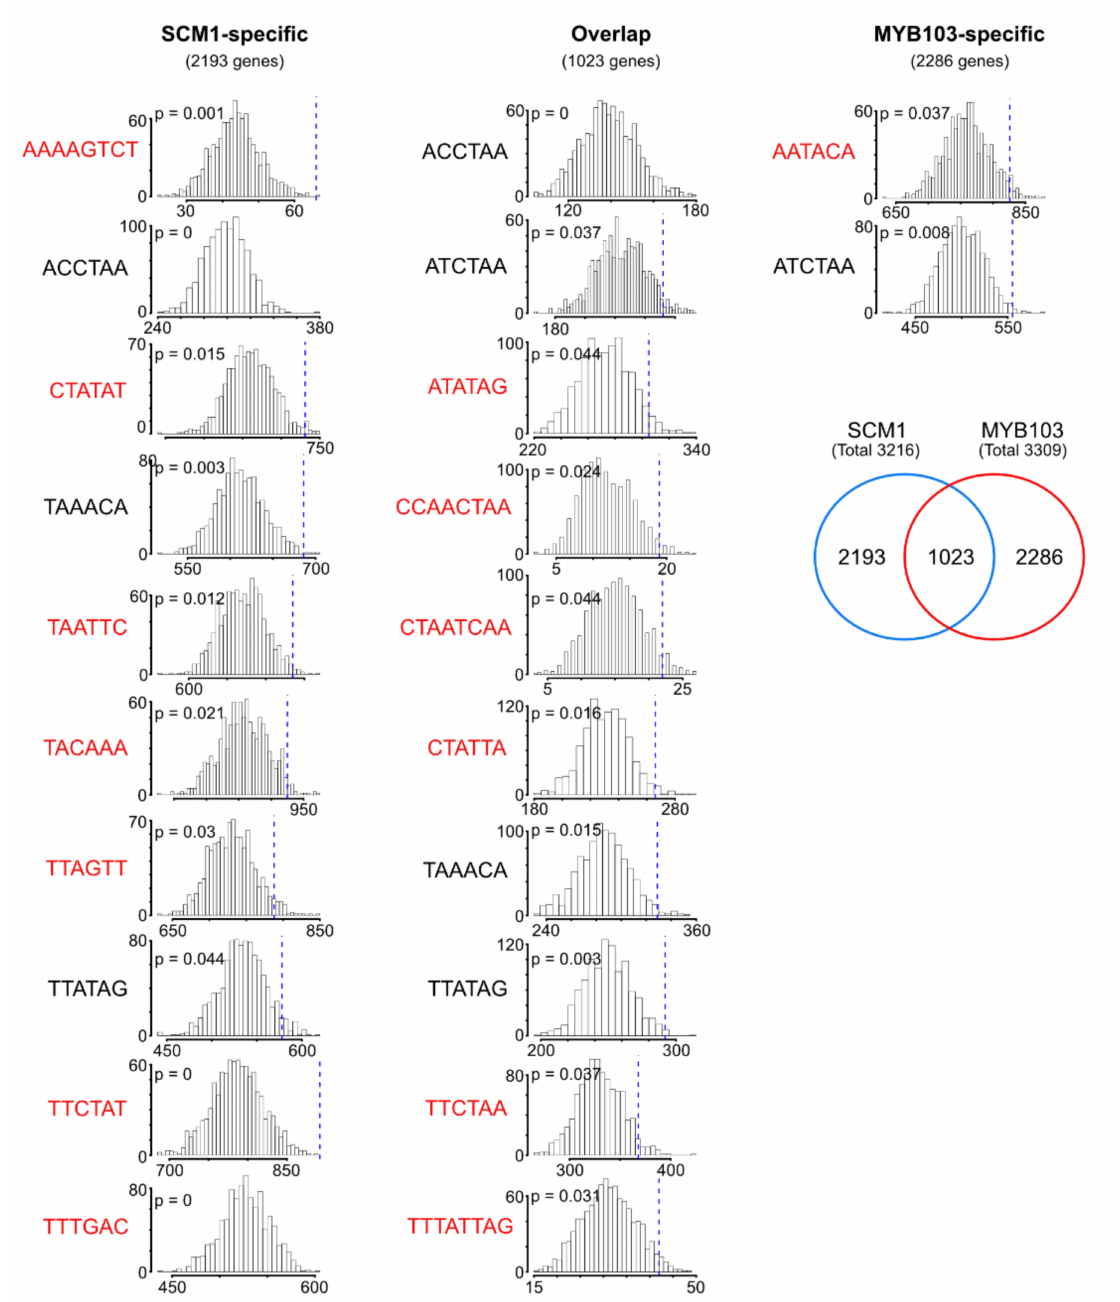
Figure 7. Comparison of motifs discovered in the genes induced by expression of the lower-tier MYB factors SCM1 and MYB103. Motifs were discovered in regions 2000 bp upstream and 200 bp downstream of the start codon of genes significantly and more than 2-fold induced by expression of either MYB TF, or by both, followed by enrichment analyses. Histograms depict occurrence of the indicated motifs in DEG regulatory regions or randomly sampled regions in 1000 itera- tions. Comparison of motifs derived from the MYB factors demonstrates that the majority of motifs (red) are specific to one of the TFs, in line with the limited overlap of